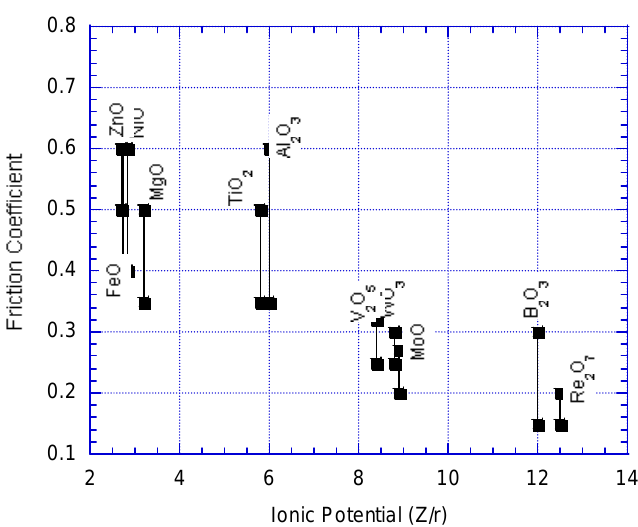
Figure 1 . Relationship between friction coefficients and ionic potentials of certain oxides [1]. Spread shows upper and lower friction values reported by different authors in the literature for each oxide over a range of